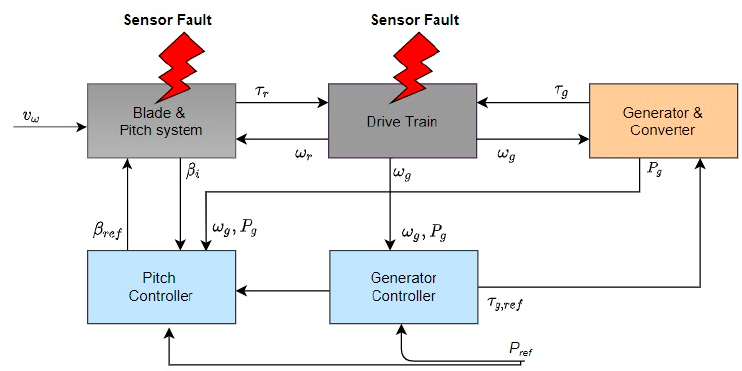
Figure 1. Interconnection of subsystems of the wind turbine in benchmark.